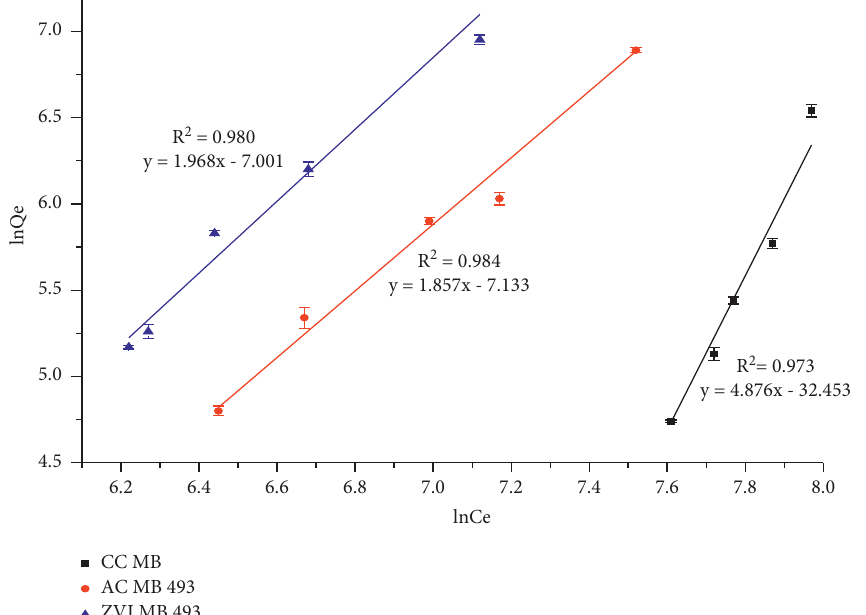
Figure 9: Freundlich adsorption isotherm for the removal of β -carotene onto CC MB, AC MB 493, and ZVI MB 493 at 95 °